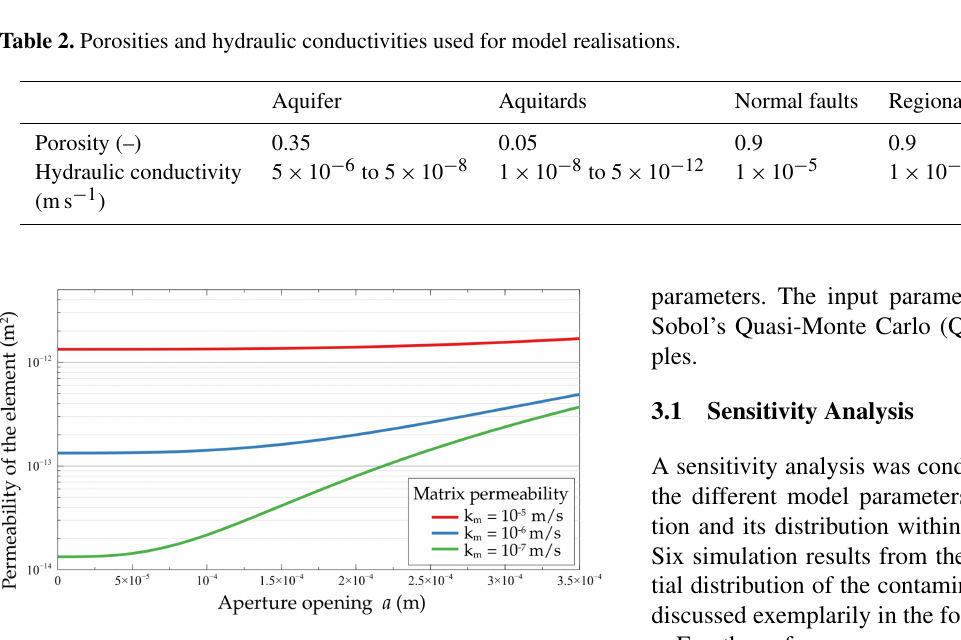
Figure 4. Permeability changes as function of the fault aperture bandwidth calculated by the mechanical model for rock matrix per- meabilities representative for the Máza-Váralja study